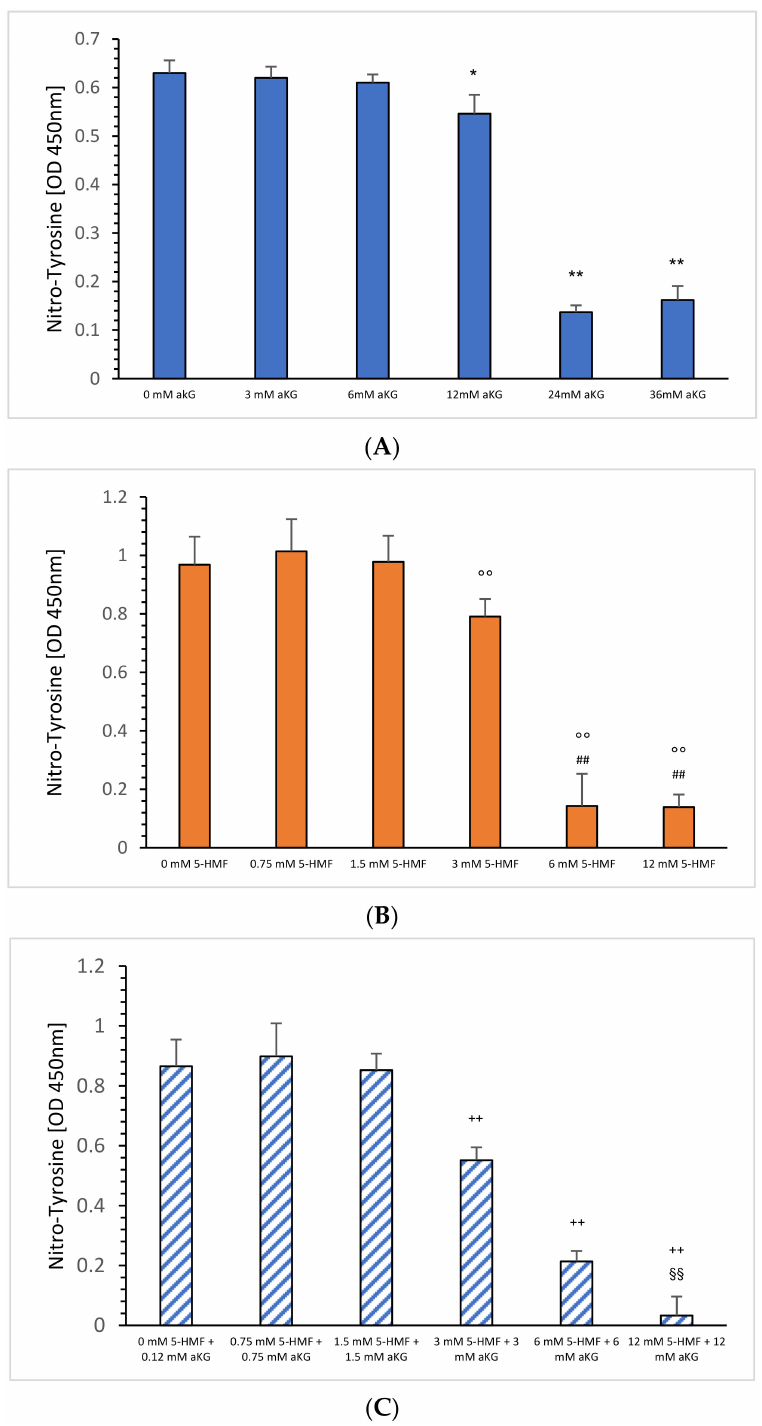
Figure 2. Estimation of nitro-tyrosine residues using ONOO − as the nitrating reagent incubated with ( B ) 0.75, 1.5, 3, 6 and 24 mM 5-HMF ( n = 5); 0.75, 1.5, 3, 6 and 24 mM combined solution of aKG + 5-HMF ( C ); ( n = 5). ( A ) presents data from Greilberger et al. (2021) [4] on the antinitrating effect on tyrosine residues using 3, 6, 12, 24 and 36 mM aKG ◦◦ p < 0.01: significance between 3, 6 and 12 mM 5-HMF compared to 1.5 mM 5-HMF. ## p < 0.01: significance between 6 and 12 mM 5-HMF compared to 3 mM 5-HMF; ++ p < 0.01: significance between combined 3, 6 and 12 mM 5-HMF + aKG and 1.5 mM combined 5-HMF + aKG; §§ p < 0.01: significance between combined 6 mM 5-HMF + aKG and combined 12 mM 5-HMF + aKG; * p < 0.05: significance between 12 and 6 mM aKG; ** p < 0.01: significance between 24 or 36 mM and 12 mM